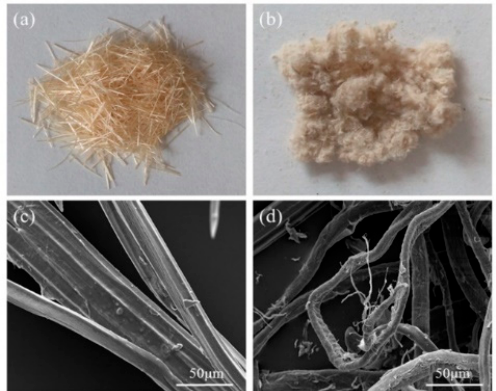
Figure 1. Digital photographs and SEM images of fibers, before screw extrusion steam explosion (SESE) pretreated ( a , c ) and after SESE pretreatment ( b , d ).